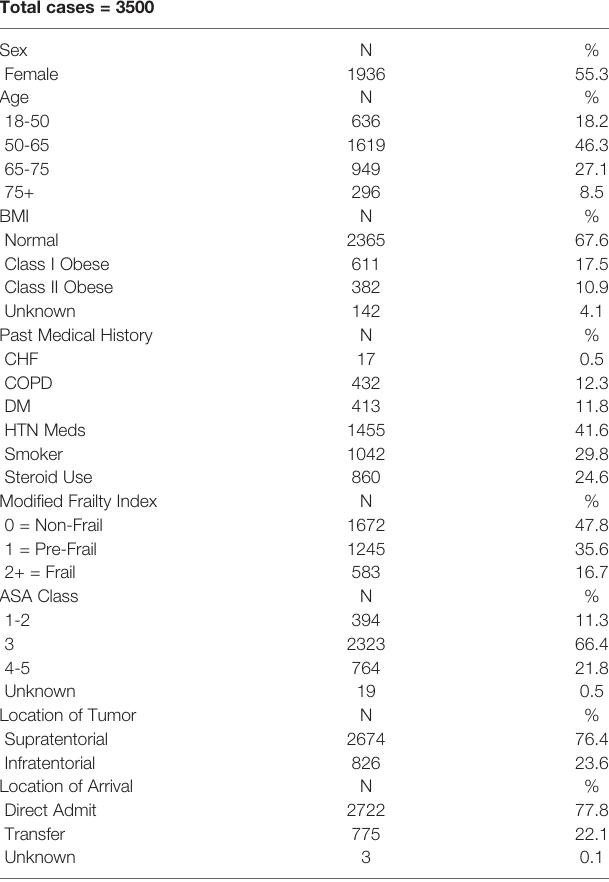
TABLE 1 | Clinical